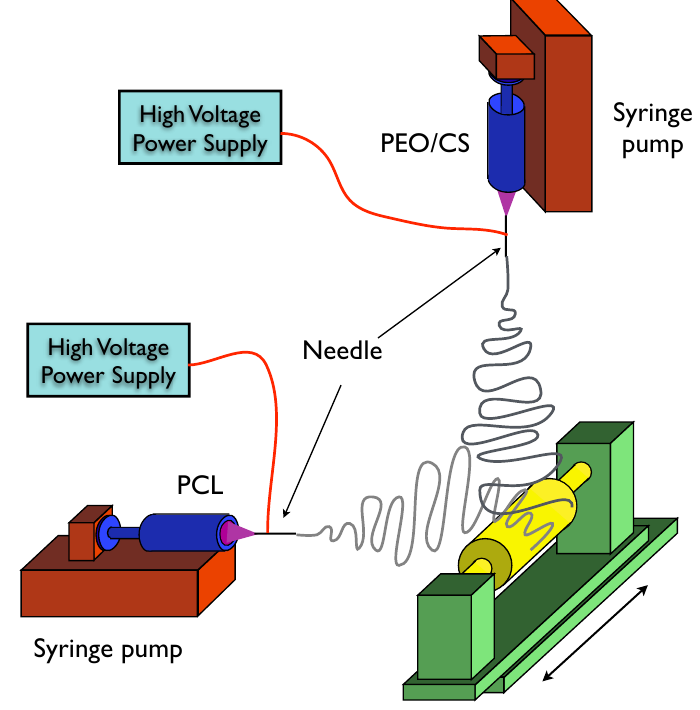
Figure 1. Electrospinning setup used in this work. The PCL solution was electrospun horizontally while the PEO/CS solution was electrospun vertically. The cylindrical collector made slow rotating and translating movements (3 rpm). Table 1. Mat designation, PCL-to-CS mass ratio in the electrospun mats, CS flake size, CS concen- tration in the PEO solutions, and flow rate of PEO/CS solution during electrospinning.